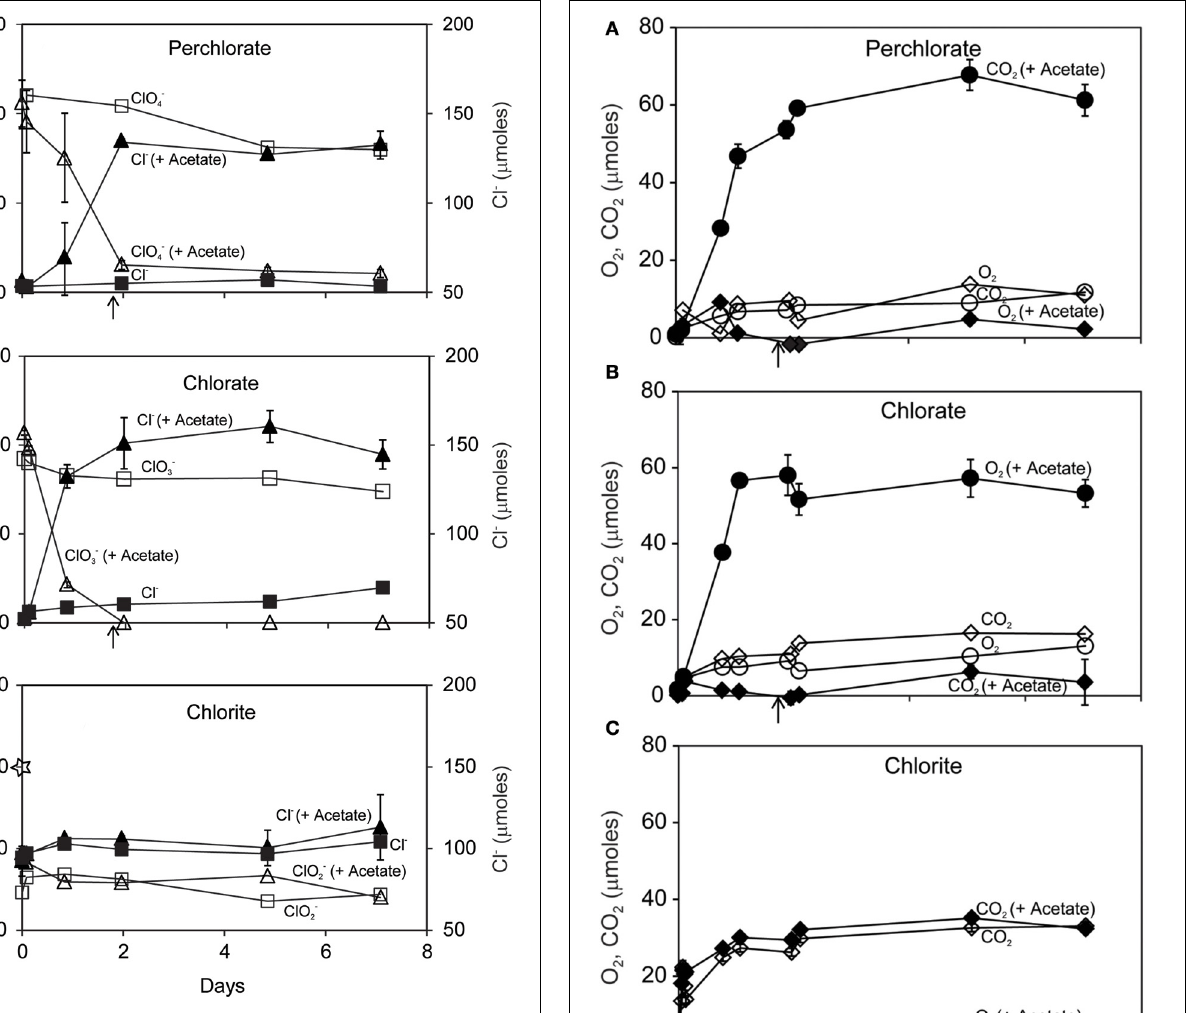
FIGURE 1 | Time course of reaction of D. agitata CKB following addition of 10mM ClO − 4 (A), ClO − 3 (B), or ClO − 2 (C) showing consumption of added substrate (open symbols) and production of Cl − (closed symbols). Triangles symbolize incubations with added acetate (5mM) while squares symbolize incubations without added acetate. Triangles represent the mean and range of duplicate samples. Absence of bars indicates that the error is smaller than the symbol size. Squares represent single samples. Arrows in (A) and (B) correspond to the time when 5mM added acetate was completely consumed. The star in (C) corresponds to the initial amount of ClO − 2 added. ( Figure 4B ) indicating that direct contact of cells was not required for methane consumption to occur.